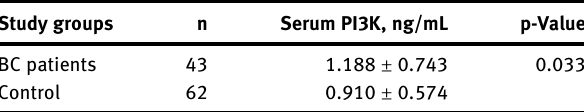
Table  : The serum PI  K levels in BC patients and control group.